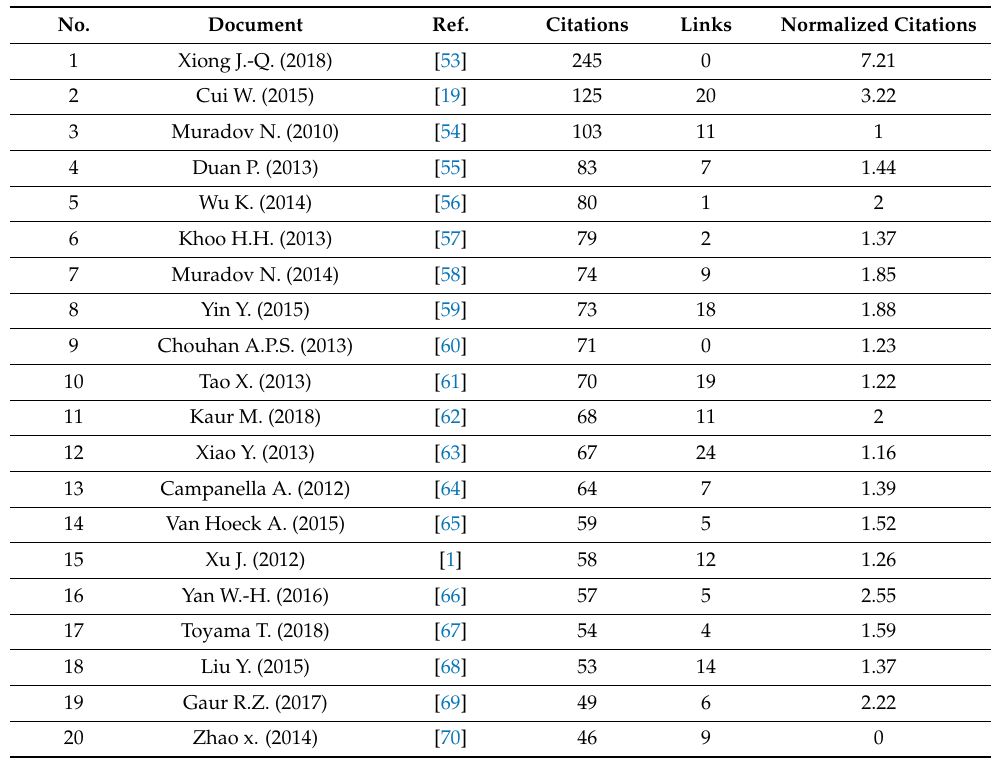
Table 3. Documents with high impacts based on normalized